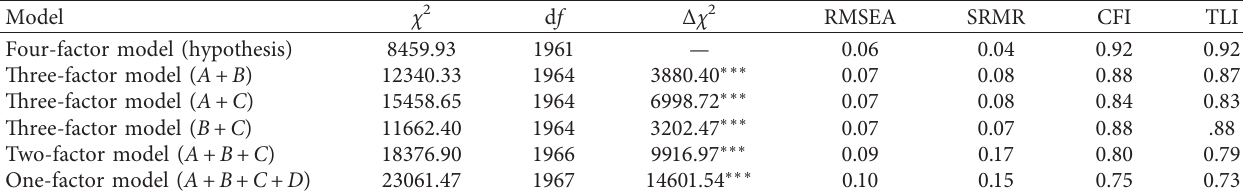
Table 1: Confirmatory factor analysis results.